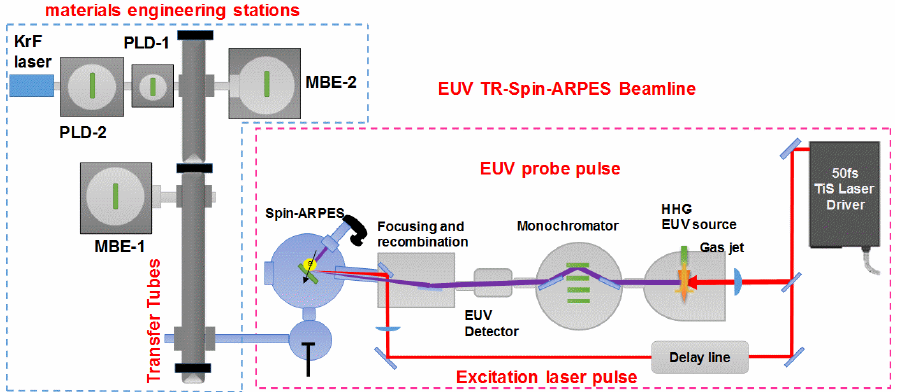
Figure 1. Ultrafast spintronic materials facility has two integral, interconnected parts: the EUV TR-Spin-ARPES Beamline and the materials engineering stations.